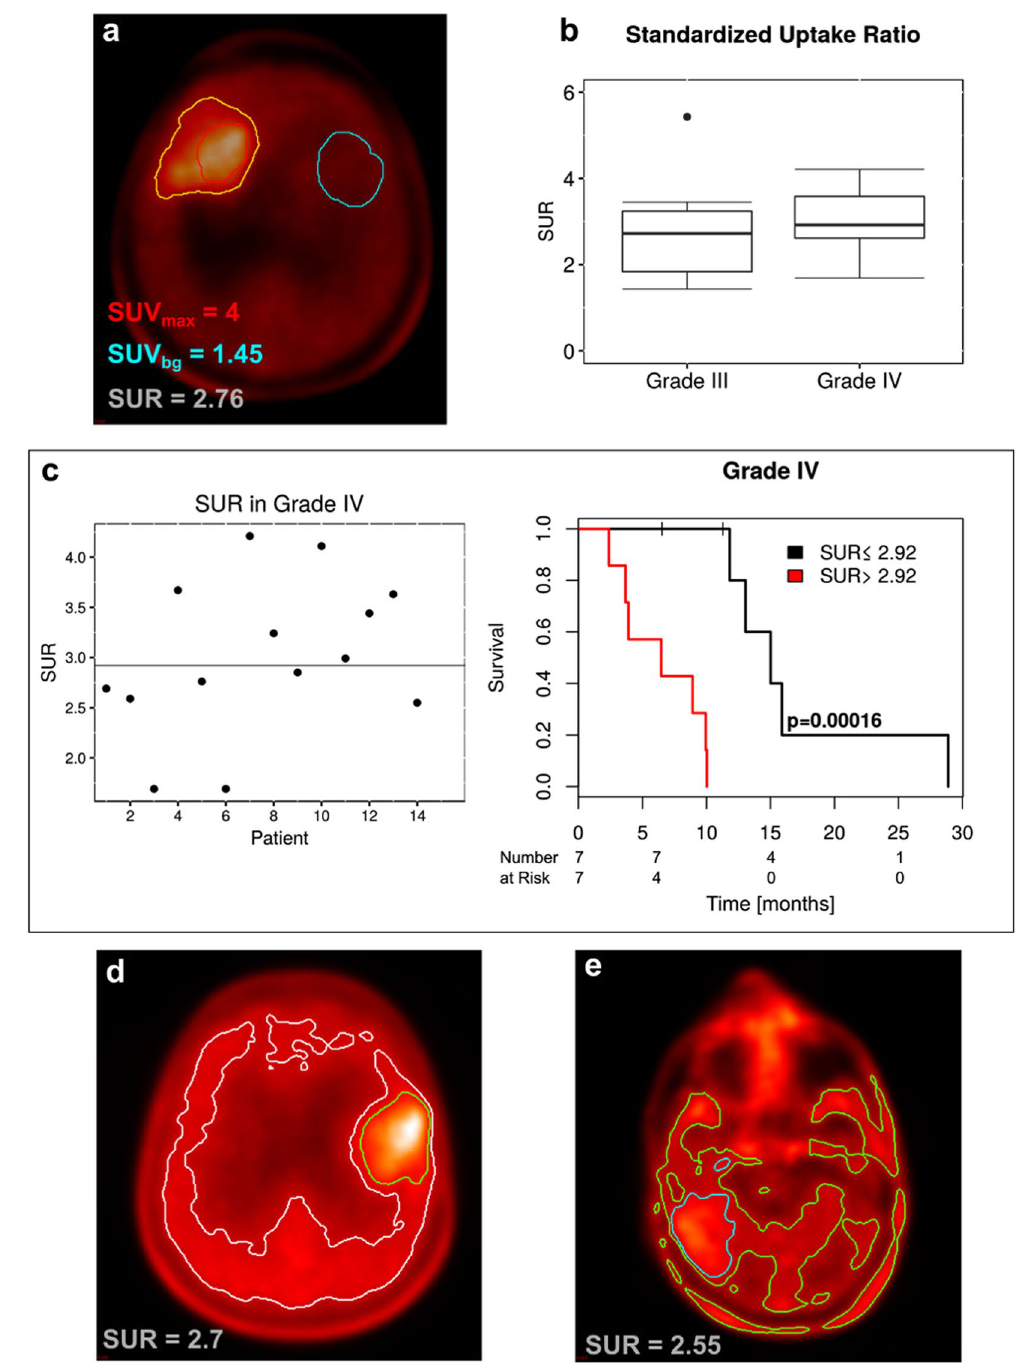
Figure 2. Prognostic relevance of 18 F-FET PET based standardized uptake ratio (SUR). SUR is calculated by normalizing SUV max in the tumor lesion to the average background SUV (SUV bg ) within a region of similar size to GTV in the contralateral part of the brain, as shown ( a ). SUR was slightly but not significantly higher in grade IV glioma compared to grade III glioma ( b ). In grade IV tumors, the median value of SUR = 2.92 clearly separated patients into two prognostic subgroups as shown in KM-plot ( c ). This did not apply to grade III tumors (see supplements). For PET contouring, large interindividual heterogeneity of 18 F-FET PET uptake was found limiting the use of a fixed threshold for all patients as illustrated in two patients ( d , e ). However, based on SUR, thresholds for the reasonable applicability of isocontours could be drawn as SUR > 2.73 for an isocontour of 40%, SUR > 2.55 for an isocontour of 50% and SUR > 1.62 for an isocontour of 60%. This was not possible using SUV max